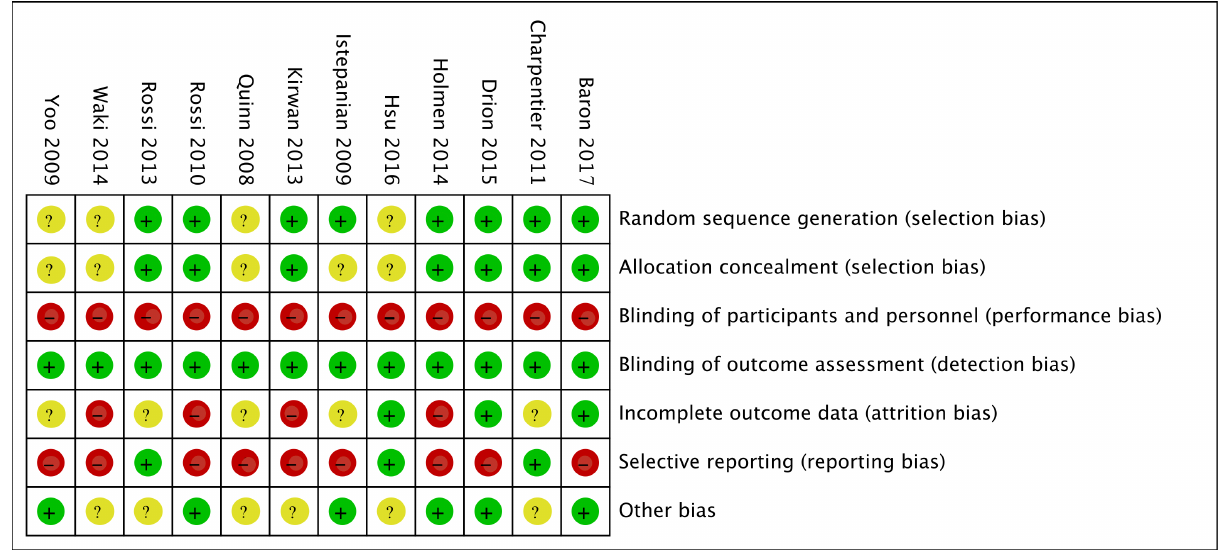
Figure 3. Risk-of-bias summary for the primary outcome (hemoglobin A 1c changes): review authors’judgments about each risk-of-bias item for each included